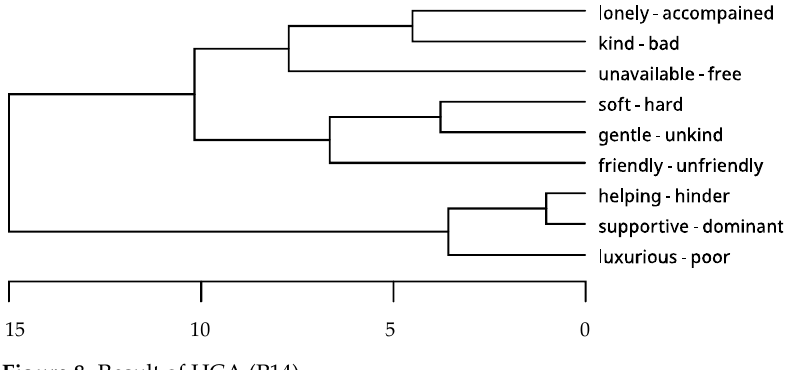
Figure 8. Result of HCA (P14).